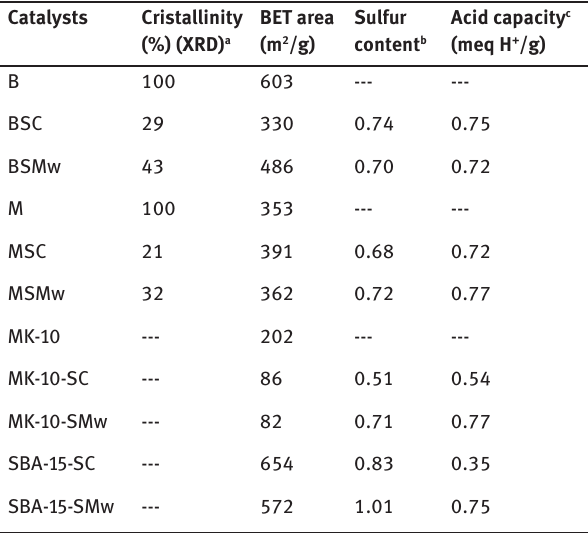
Table 1: Characterization of the sulfonated